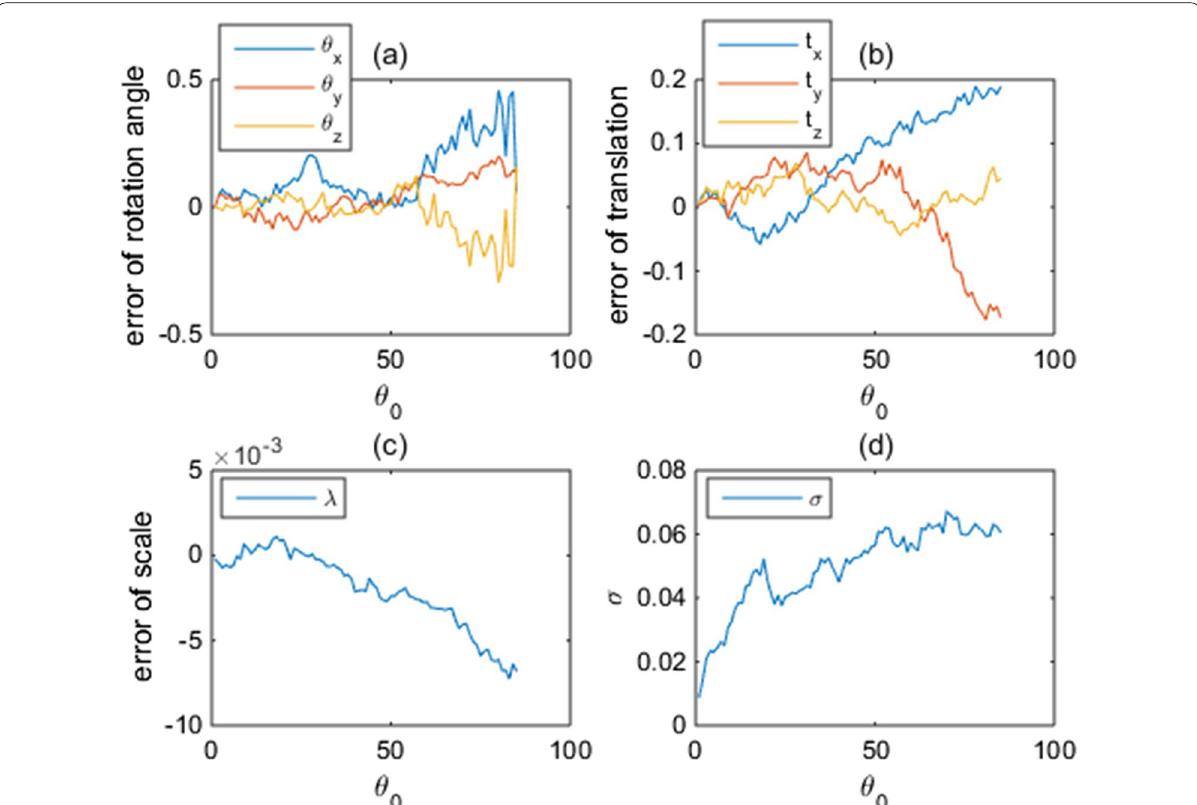
Fig. 2 The errors of computed transformation parameters and standard deviation of unit weight with different rotation angle θ 0 . Each x axis value represents the different θ 0 in degrees. Each y axis value represents different accuracy index: ( a ) error of rotation angle, in degrees. ( b ) Error of translation, in meters. ( c ) Error of scale, in no unit. ( d ) σ in